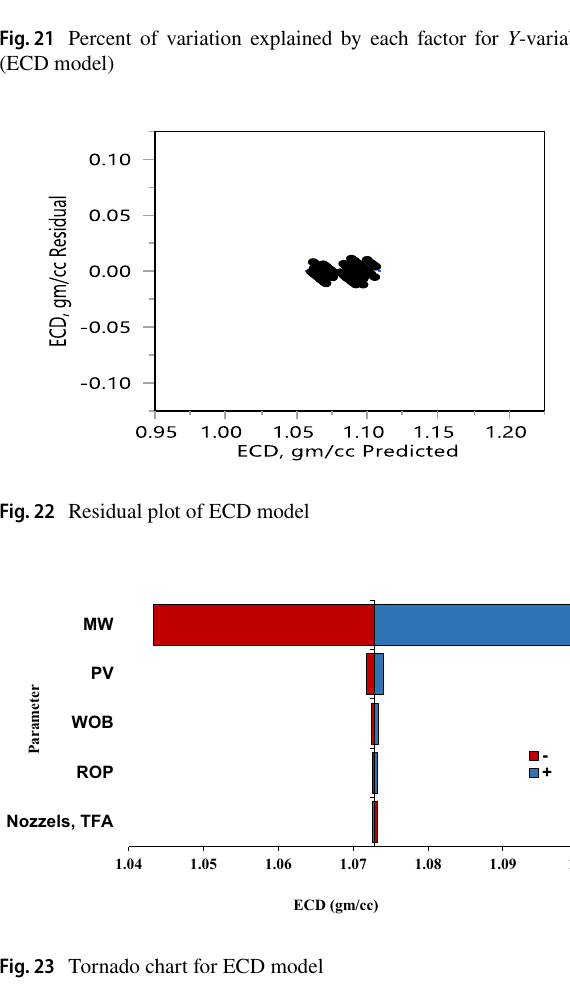
Fig. 18 VIP versus coefficient for ECD model (after refining)